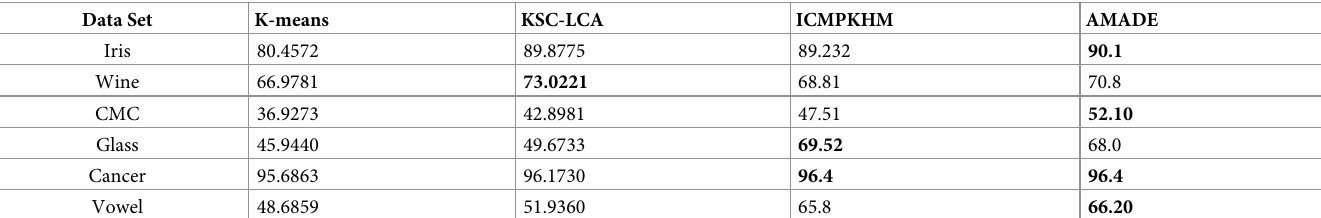
Table 12. The F-measure obtained by AMADE outperformed other clustering algorithms, where it reached the optimum F-measure value on the Iris, CMC, Cancer and Vowel datasets, while it obtained the second best results of the F-measure on Wine and Glass. The KSC-LCA algorithm achieved the best result of the F-measure on Wine dataset, and ICMPKHM algo- rithm achieved the best result on Glass and Cancer datasets. The results shown in Table 12 reveals the consistent performance of AMADE across all dataset based on the F-measure.